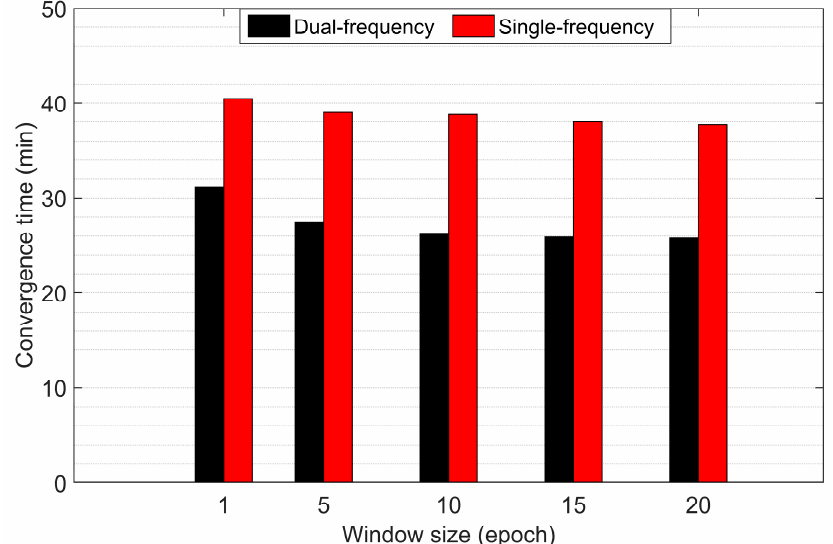
Figure 5. Convergence time using the proposed weighting approach with different smoothing window sizes for dual-frequency and single-frequency METG station.